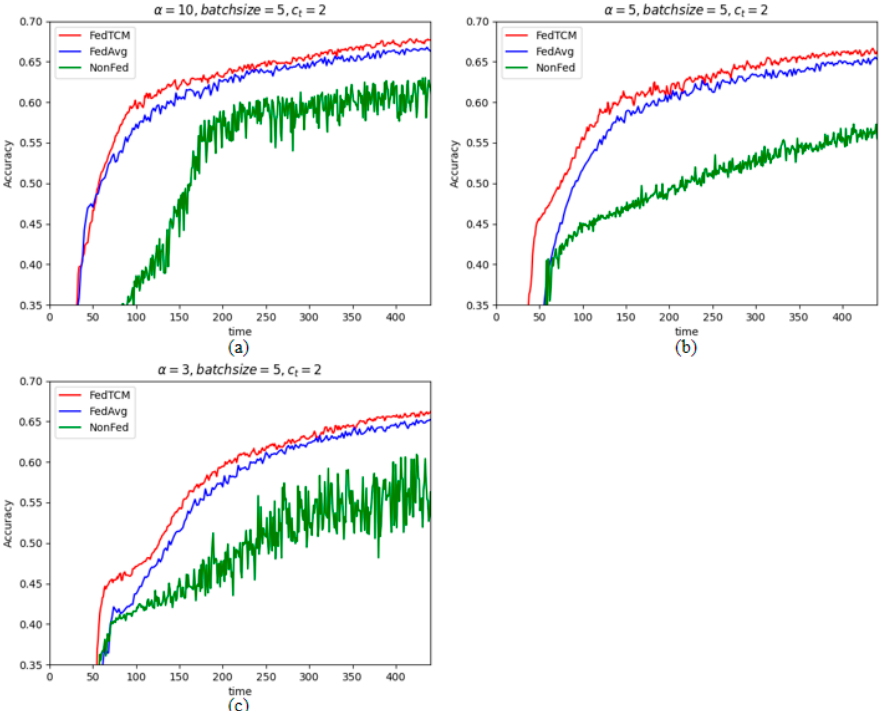
Figure 6. Comparing FedTCM with the baseline algorithm with different α at batch size B = 5, c t = 2. ( a ) FedTCM and baseline algorithms are all set 𝛼 = 10 . ( b ) FedTCM and baseline algorithms are all set 𝛼 = 5 . ( c ) FedTCM and baseline algorithms are all set 𝛼 = 3 .